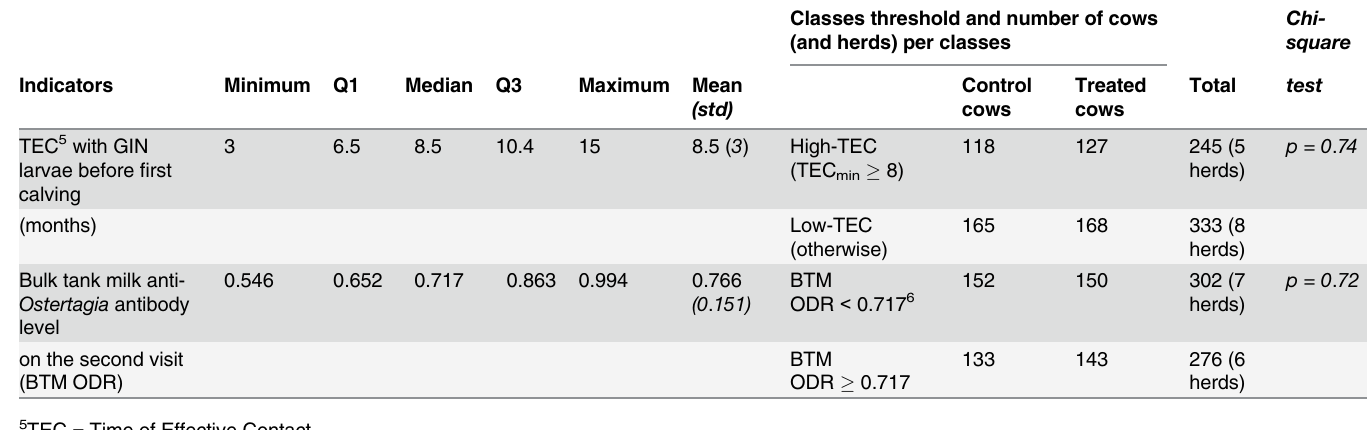
Table 4. Description of the dataset (578 cows in 13 herds, 295 treated cows, 283 control cows): distribution and classification of indicators charac- terizing herds, number of treated cows and control cows per classes for each categorized indicator.